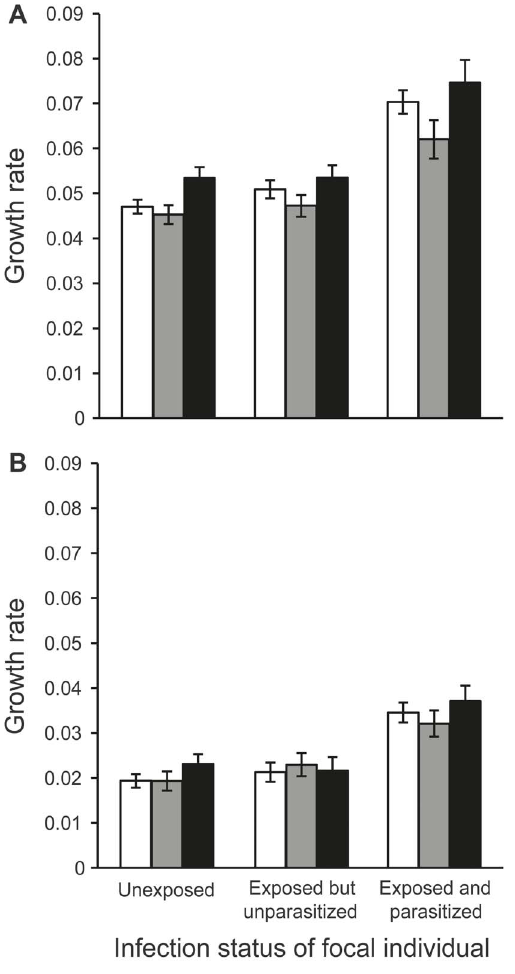
Figure 1. Growth rate of Lymnaeastagnalis snails during the experiment. Bars (size-adjusted mean 6 SE) show the specific growth rate of focal individuals with different infection status (unexposed, exposed but unparasitized, exposed and parasitized; parasite: Diplos- tomum pseudospathaceum ) maintained together with another snail individual [competitor; unexposed (white), exposed but unparasitized (grey), exposed and parasitized (black); parasite: D. pseudospathaceum ] under (A) ad libitum food supply and (B) reduced food supply (i.e. half of the average food consumption) for ten weeks.